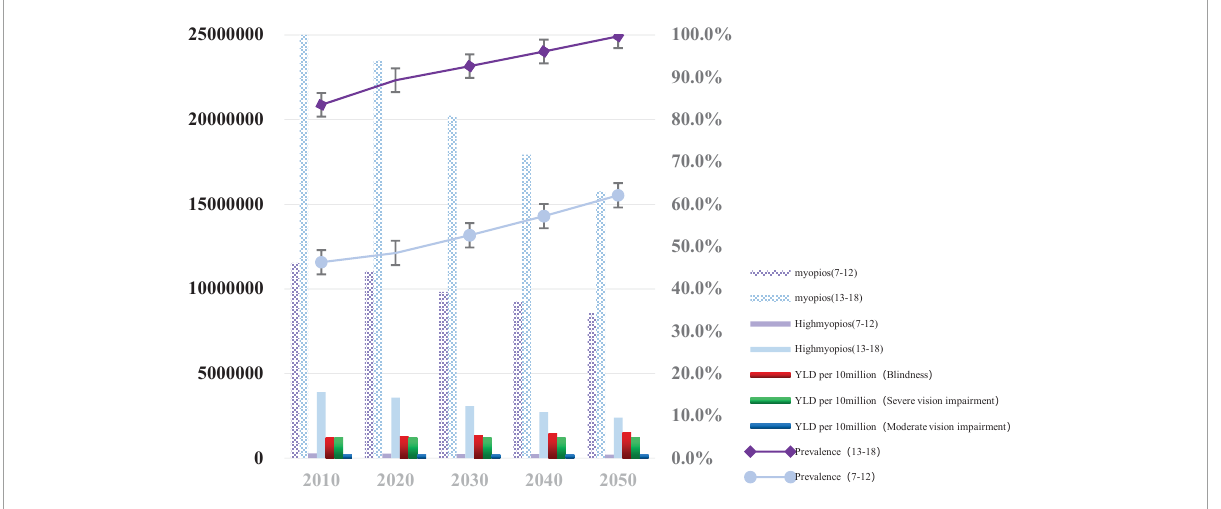
FIGURE3 Graph depicting the estimated number of children and adolescents with myopia, high myopia, and Years Lived with Disability (YLD) from 2010 to 2050 under the current intervention situation. *YLD per 10 million (Blindness: Blindness due to uncorrected refractive error per 10 million children and adolescents); YLD per 10 million (Moderate vision impairment: Moderate vision impairment due to uncorrected refractive error per 10 million children and adolescents); YLD per 10 million (Severe vision impairment: Severe vision impairment due to uncorrected refractive error per 10 million children and